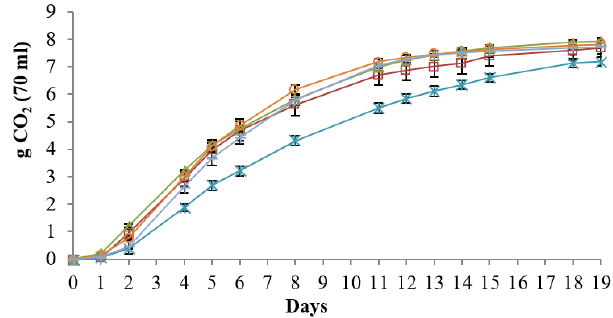
Figure 4. Fermentation kinetics of the new selected strains tested: OKAY ( ); DiSVA 705 ( ); I1 ( ); I4 ( ); B4 ( ). The graph represented the fermentation trend in NGJ. The results were the mean values and the standard deviations were represented as error bars.